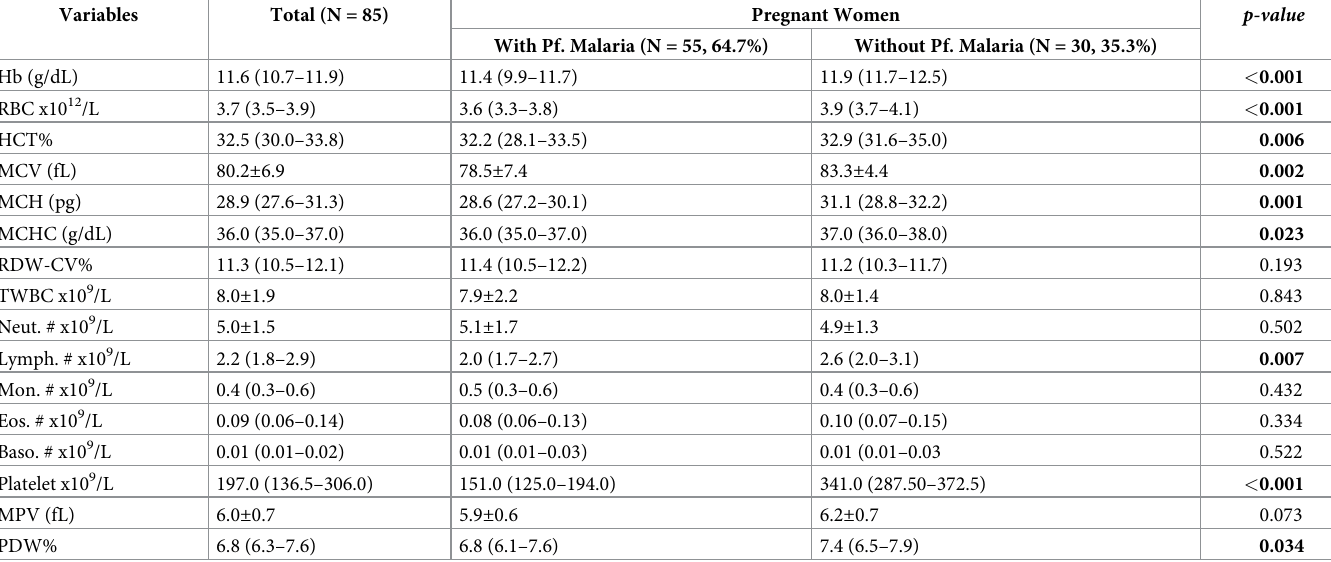
Table 2. Haemogram of the study participants stratified by the presence or absence of P . falciparum malaria. Variables Total (N = 85) Pregnant